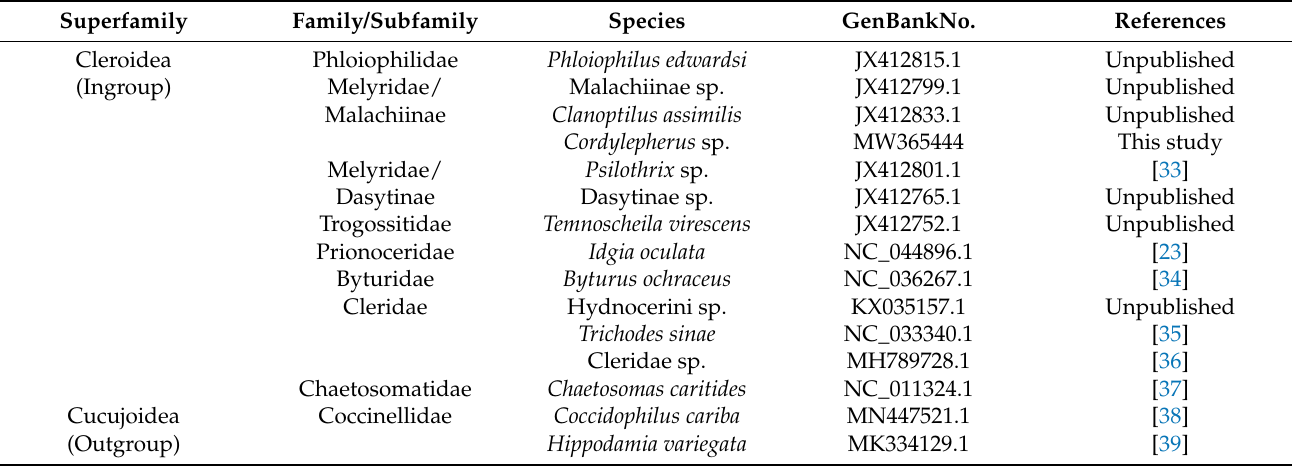
Table 1. Summary of the representative species and their mitogenome information in this study.